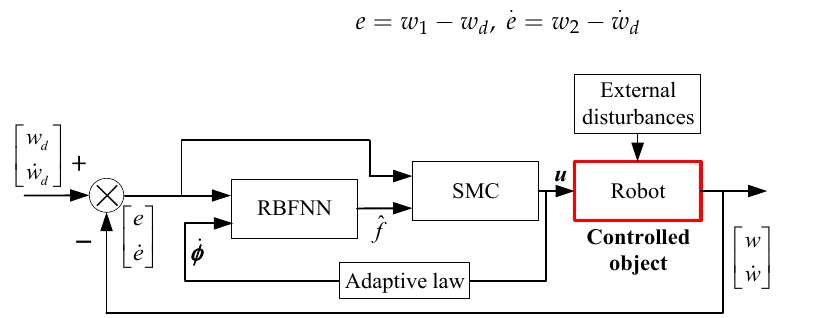
Figure 16. Robust sliding mode control of adsorption system.